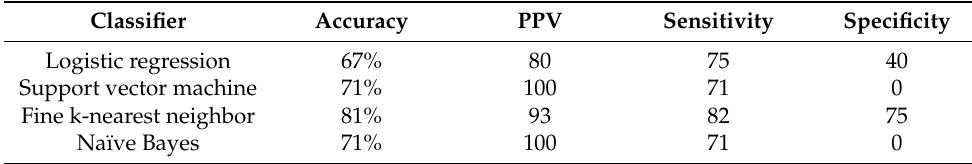
Table 4. Classifiers’ comparison based on 8-fold cross-validation. Classifier Accuracy PPV